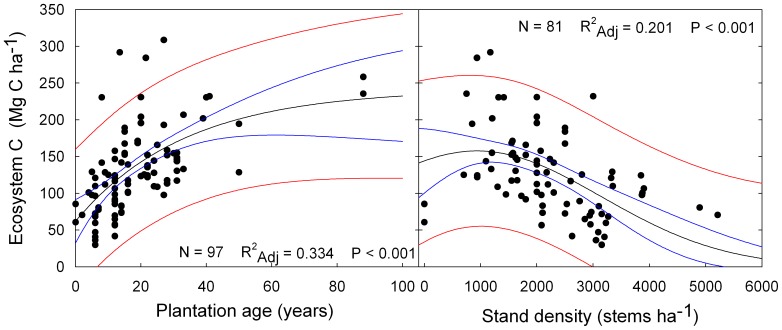
Carbon stocks in subtropical plantations for different A) rotation ages, and B) stand densities.Black lines indicate the best-fit model, blue lines 95% confidence interval and red lines 95% prediction intervals.